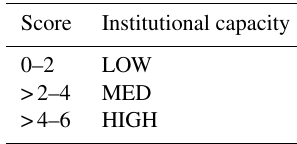
Table 4. Institutional capacity in place in transboundary upstream areas of riparian wetlands based on formal arrangements such as international water treaties, river basin organizations, legal eFlow provisions, and specific treaty